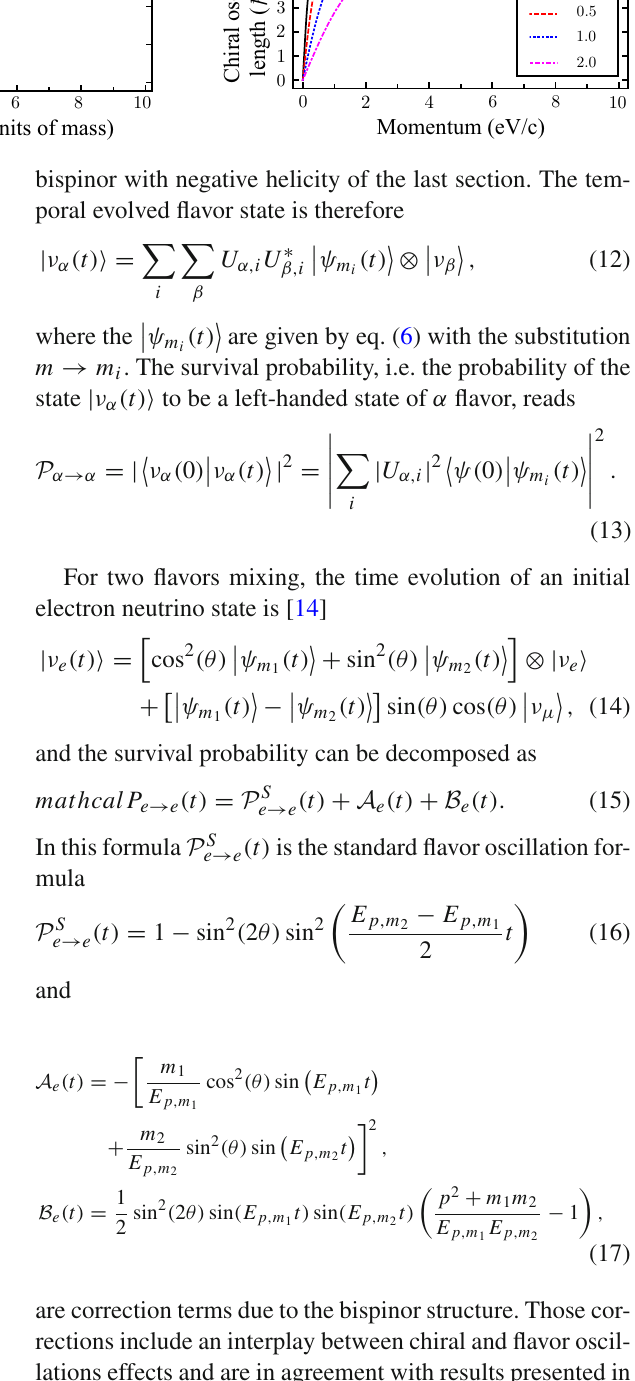
Fig. 1 a Minimum survival probability as a function of the momentum p in units of mass; b Chiral oscillation length as a function of the momentum for different values of the